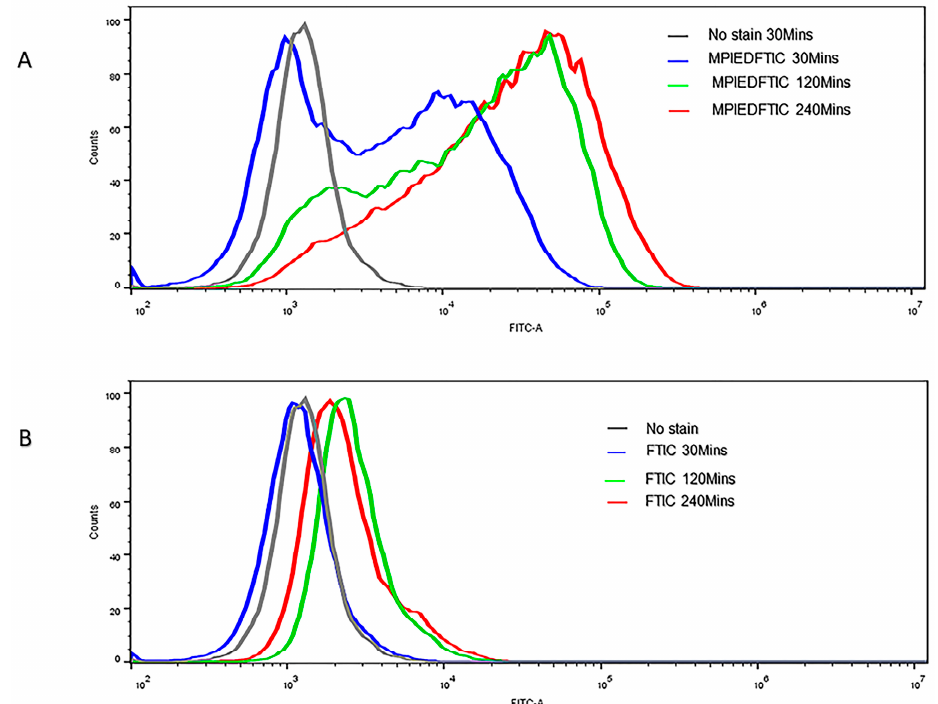
Figure 12. Show flow cytometry analysis (histogram) of RAW 264.7 macrophage cells incubated with FITC-labelled MPI ( A ) and FITC alone ( B ) at a different time point (30 min, 120 min, and 240 min). The histogram of cell count versus FITC intensity (FITC-A denotes FITC area). Data is representative of three sets of experiments.